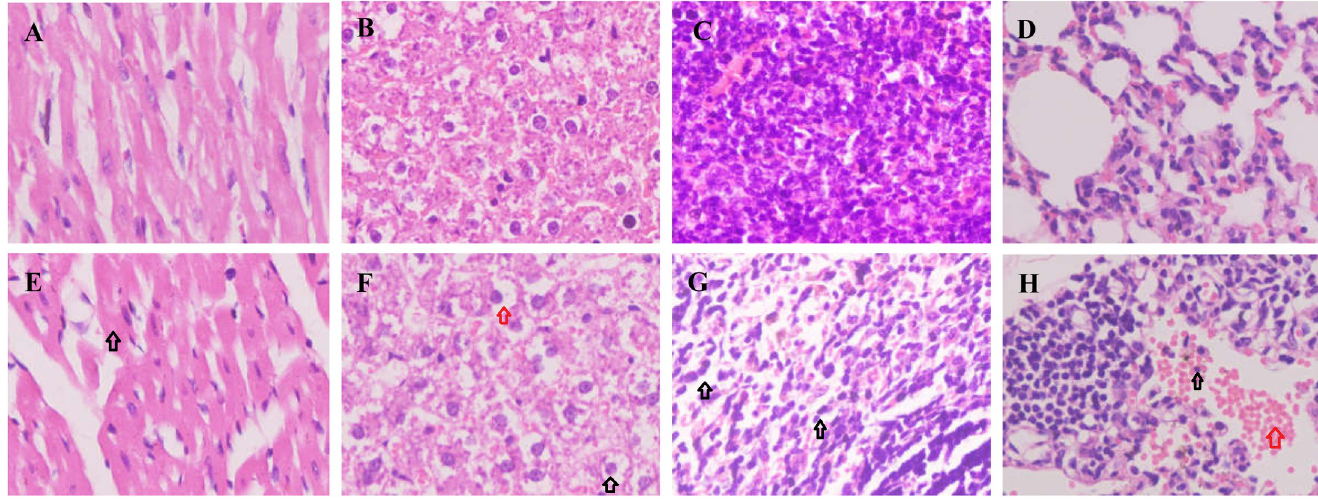
Fig 10. Histological examination of the heart, liver, spleen, and lung sections. Organ sections were stained with hematoxylin-eosin (HE). Organ sections were made and stained with HE. Mildly swollen cardiomyocytes (E, the black arrow) and hepatocytes (F, the black arrow) were found in the Uox -/- rats’ heart sections and liver sections, respectively. There could be fat accumulation in the hepatocytes’ cytoplasm, because the vacuolation usually made by fats was seen near the nucleus (F, the red arrow). The decreased splenocytes and the increased interstitial tissues (G, the black arrows) were also found in the Uox -/- rats’ spleen sections. In the Uox -/- rats’ lung sections (H), exudative inflammatory cells (the black arrow) and even red blood cells (the red arrow) were seen. A, the heart of the wild-type rat; B, the liver of the wild-type rat; C, the spleen of the wild-type rat; D, the lung of the wild-type rat; E, the heart of the Uox -/- rat; F, the liver of the Uox -/- rat; G, the spleen of the Uox -/- rat; and H, the lung of the Uox -/- rat. Picture = 130 μ m × 175 μ m.